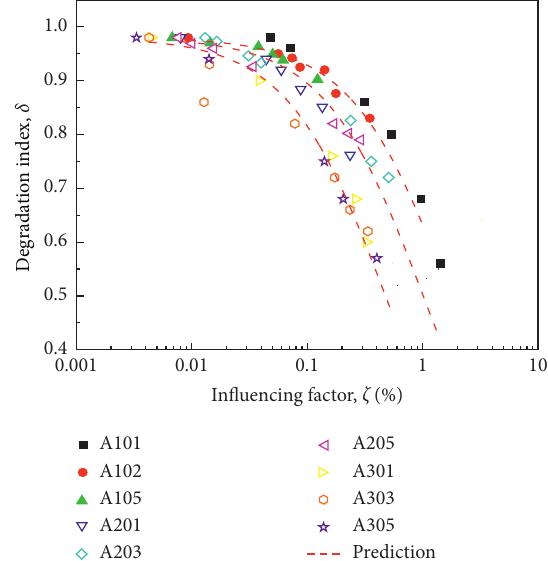
Figure 16: Relationship of the degradation index δ − ζ for different loading frequencies f